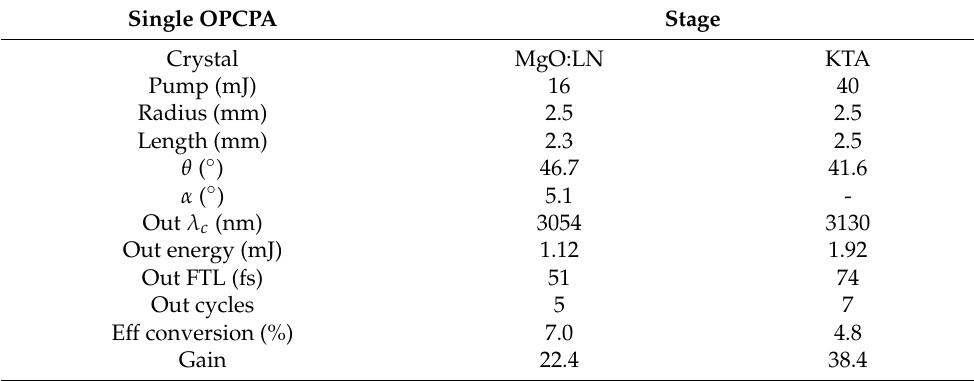
Figure 2. Results for a single non-collinear MgO:LN-based amplification stage. ( Top ) output energy and compressed pulse duration vs. ( left ) non-collinear angle α for L = 2.3 mm and ( right ) crystal length L for α = 5.1 ◦ . The circled points mark the optimum combination of both parameters. ( Bottom left ) Input ( shaded ) and output ( blue ) spectra for the optimal parameters. ( Bottom right ) Spatiotemporal profile of the optimized output pulse with 1.12 mJ and 51 fs (FTL). Table 2. Amplification parameters and output values of the proposed single KTA and MgO:LN OPCPA configurations for few-cycle,